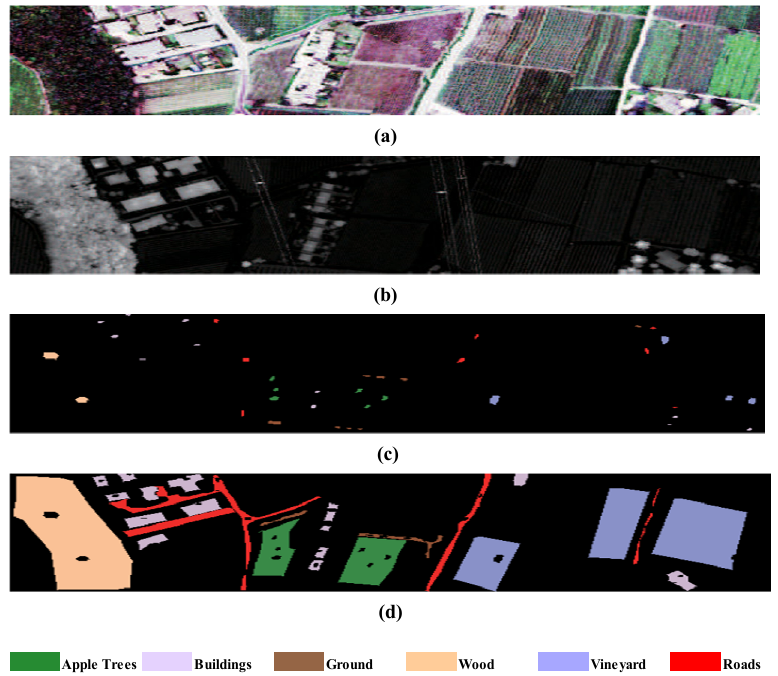
Figure 6. Trento: ( a ) The LiDAR-derived DSM image. ( b ) Grayscale image for the LiDAR data. ( c ) Training data map. ( d ) Testing data map. Table 2. Sample distribution of Trento dataset.